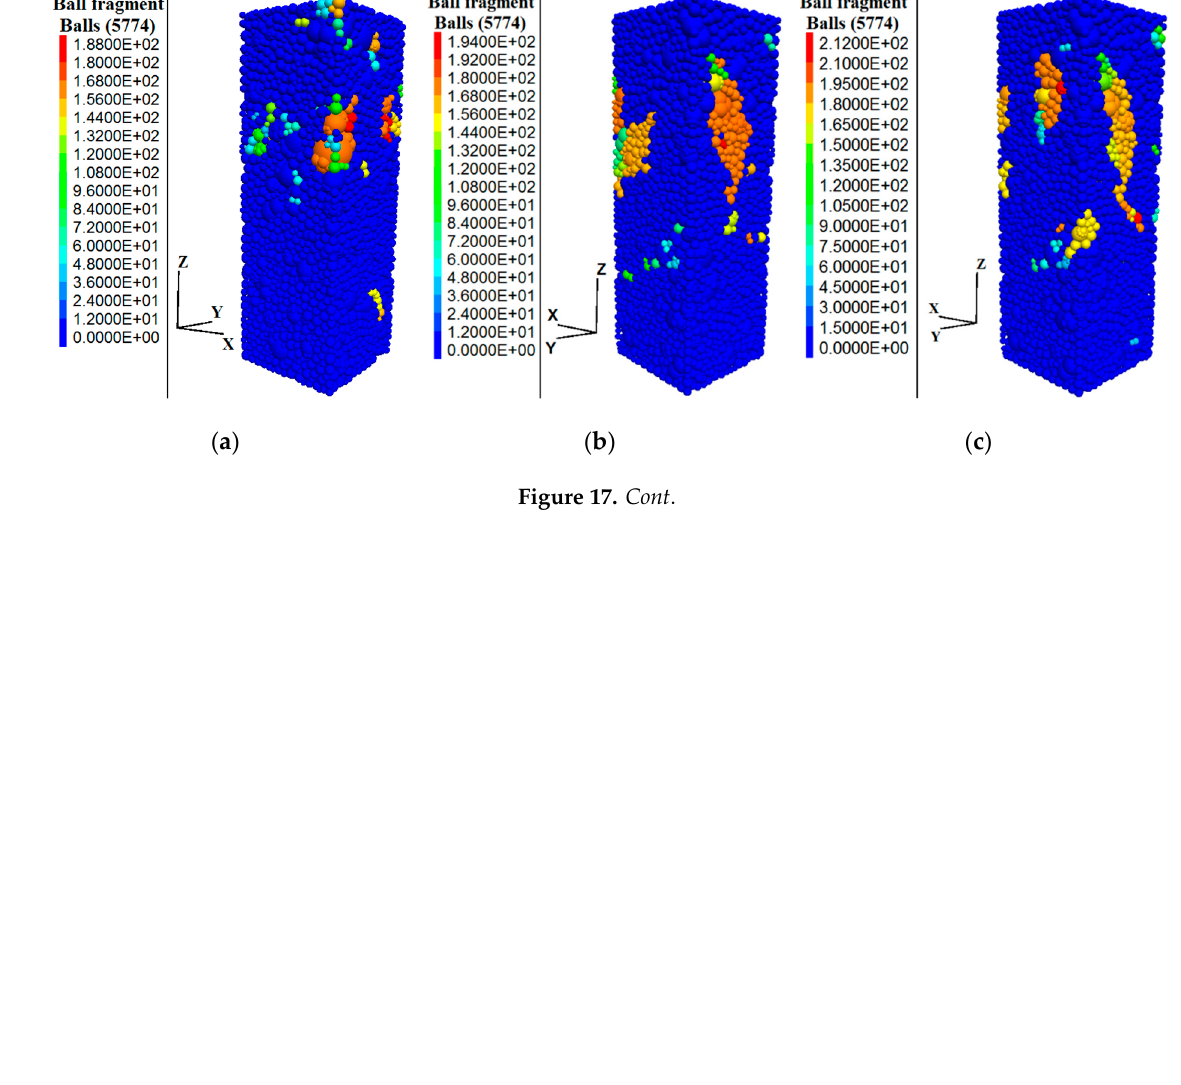
Figure 16. Number of fragments at the third stage point of freezing–thawing concrete.